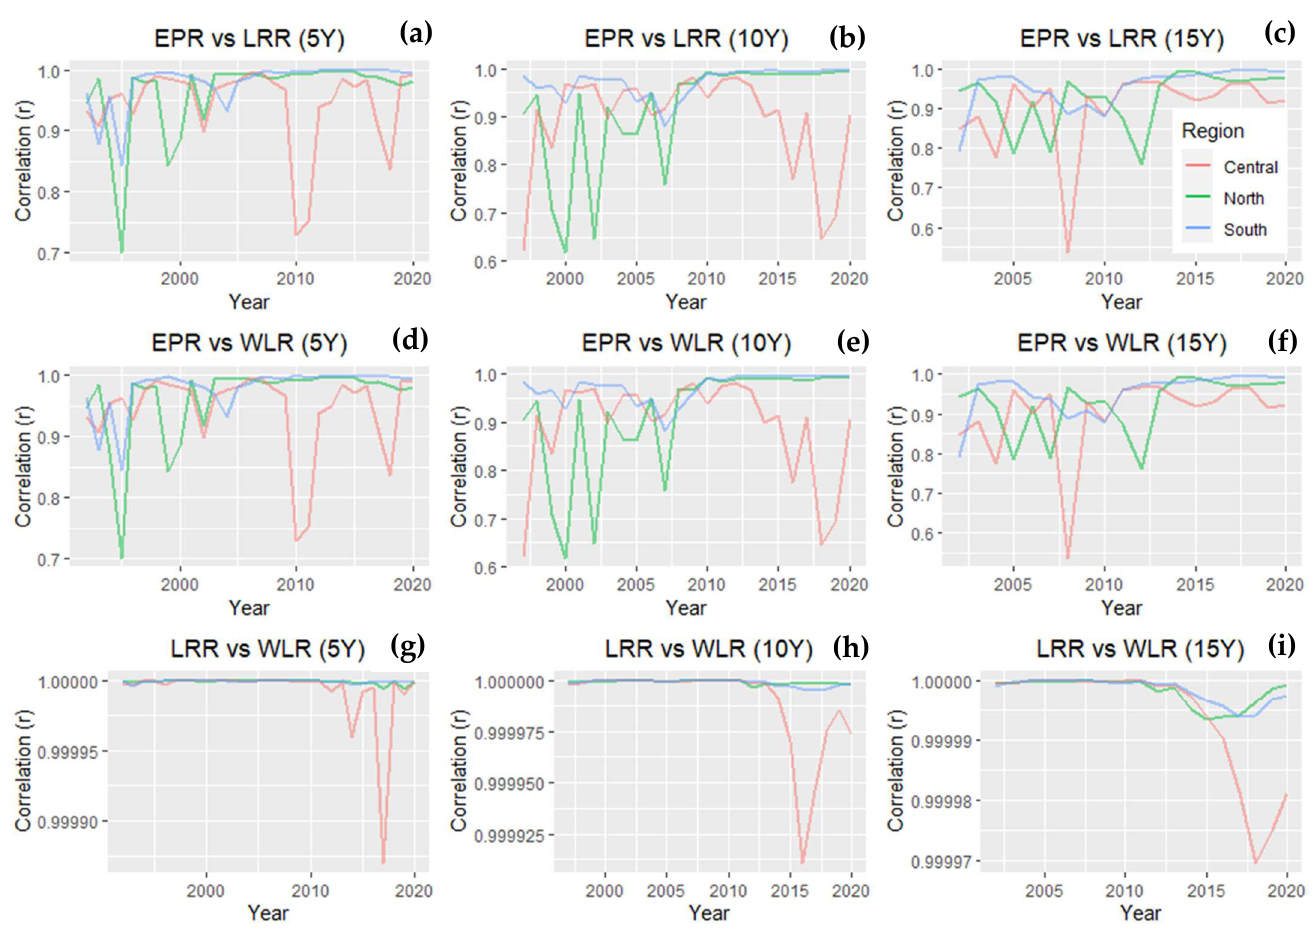
Figure 3. Spatio-temporal pattern of the Pearson correlation (r) values between different methods used to calculate historical shoreline change rates: ( a ) 5 years’ time depth EPR vs. LRR, ( b ) 10 years’ time depth EPR vs. LRR, ( c ) 15 years’ time depth EPR vs. LRR, ( d ) 5 years’ time depth EPR vs. WLR, ( e ) 10 years’ time depth EPR vs. WLR, ( f ) 15 years’ time depth EPR vs. WLR, ( g ) 5 years’ time depth LRR vs. WLR, ( h ) 10 years’ time depth LRR vs. WLR, and ( i ) 15 years’ time depth LRR vs.